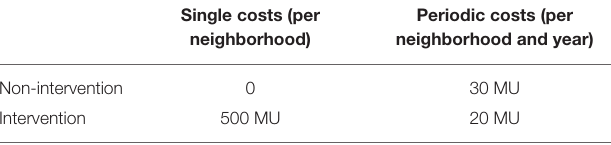
TABLE 4 | Intervention costs.